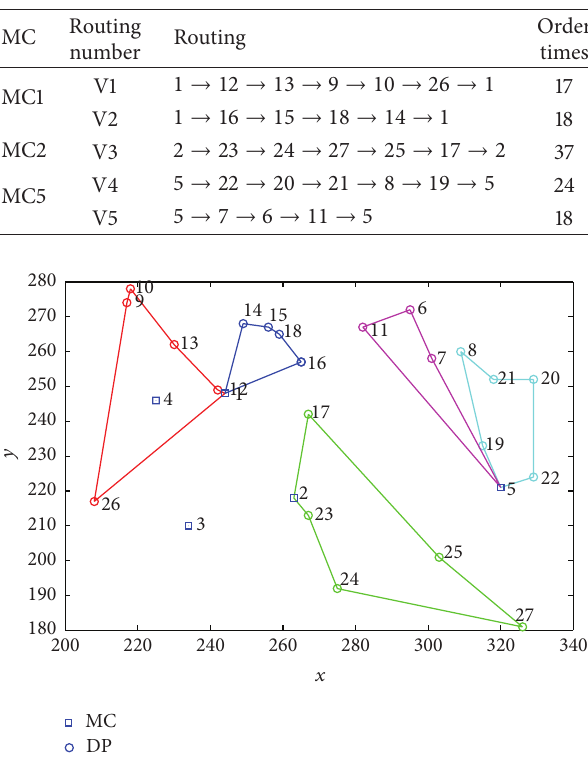
Figure 2: Topological structure of the network.